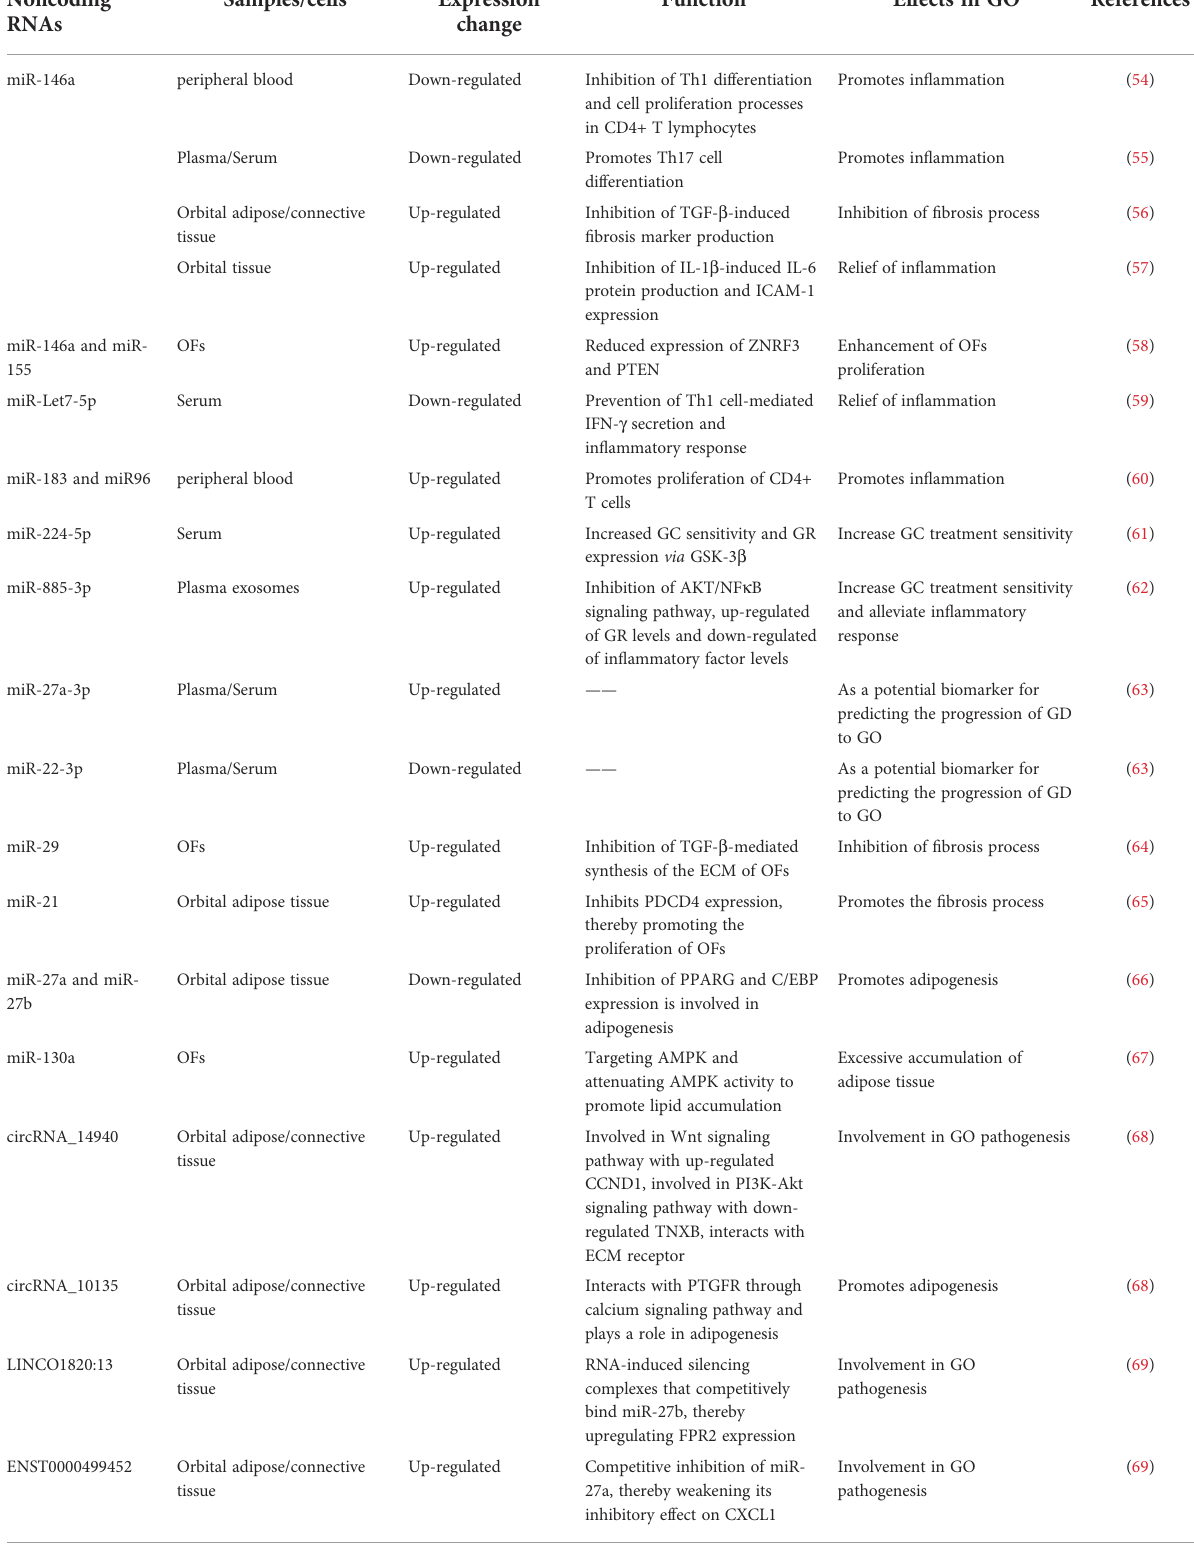
TABLE 1 The role of non-coding RNAs in the pathogenesis of